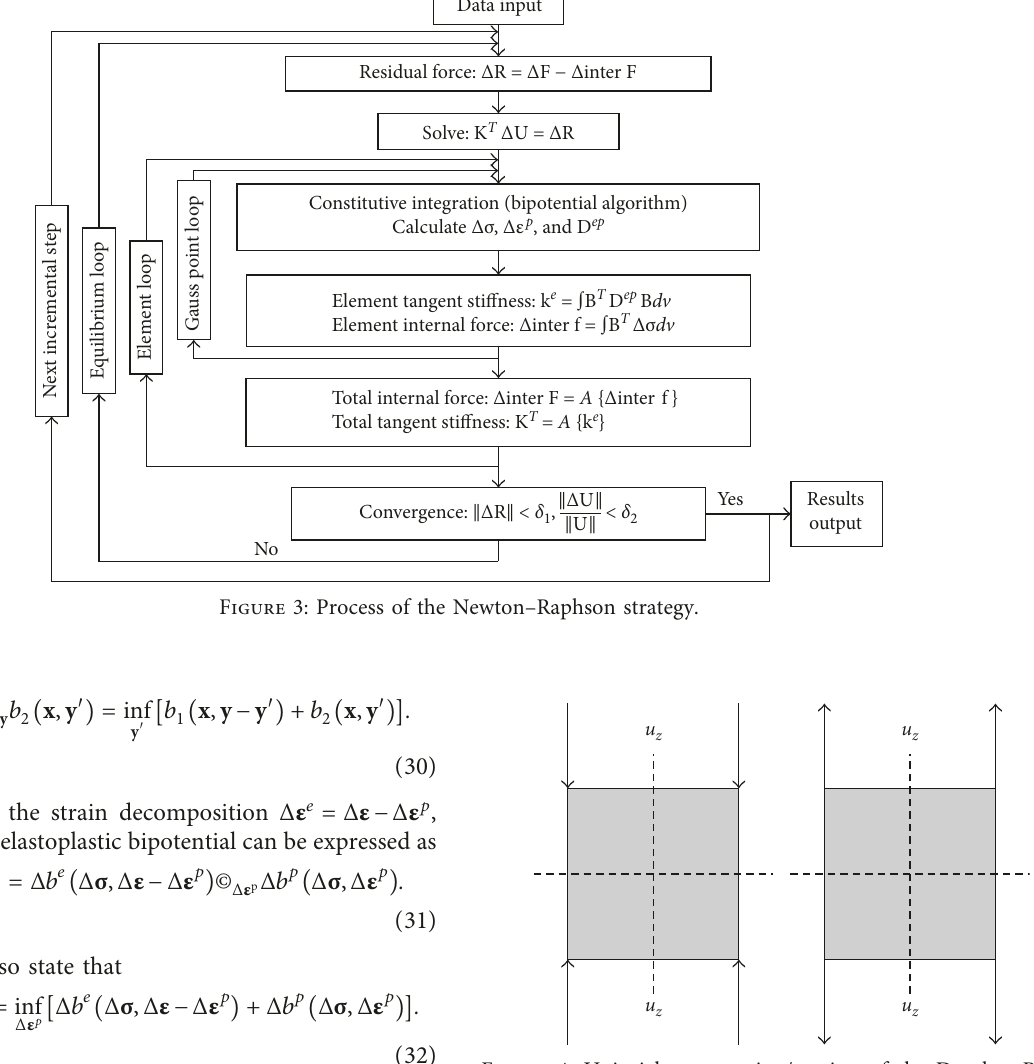
Figure 4: Uniaxial compression/tension of the Drucker–Prager model